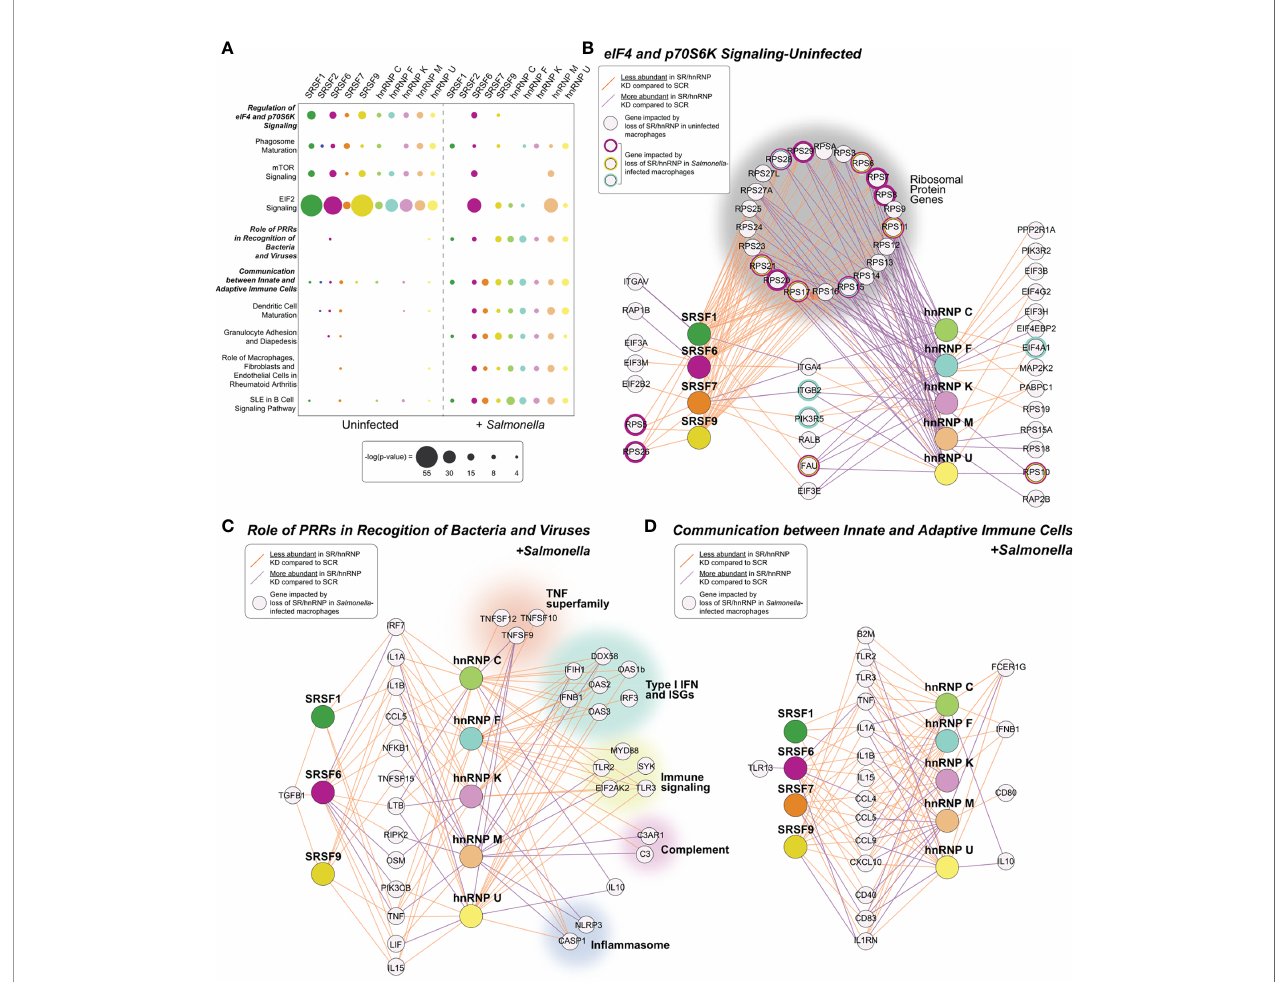
FIGURE 2 | Pathways enriched for SR/hnRNP-dependent DEGs differ between uninfected and Salmonella -infected macrophages. (A) Canonical Ingenuity pathway analysis (IPA) of functional cellular pathways enriched for differentially expressed genes (DEGs) in uninfected (UN) and Salmonella -infected (+SAL) SR and hnRNP knockdown RAW 264.7 macrophages. Pathways enriched in eight or more knockdown cell lines in at least one condition are shown. Statistical enrichment is expressed as [-log (p-value)]. (B) Network diagrams showing DEGs from the IPA category “ eIF4 and p70S6K Signaling ” from each SR/hnRNP knockdown cell line in uninfected and Salmonella infected RAW 264.7 macrophages. Only SR/hnRNPs that showed DEG enrichment for the eIF4 pathway are shown. (C) As in (B) but for DEGs in Salmonella -infected SR/hnRNP knockdown cell lines in the IPA category “ Role of Pattern Recognition Receptors in Recognition of Bacteria and Viruses. ” (D) As in (B) but for the IPA category “ Communication between Innate and Adaptive Immune Cells. ” Purple lines connect SR or hnRNPs with target genes whose expression is upregulated in knockdown vs. SCR control macrophages. Orange lines connect SR or hnRNPs with target genes whose expression is downregulated in knockdown vs. SCR control macrophages. Cut-off for inclusion in the IPA was p < 0.05 for differential expression between knockdown and SCR